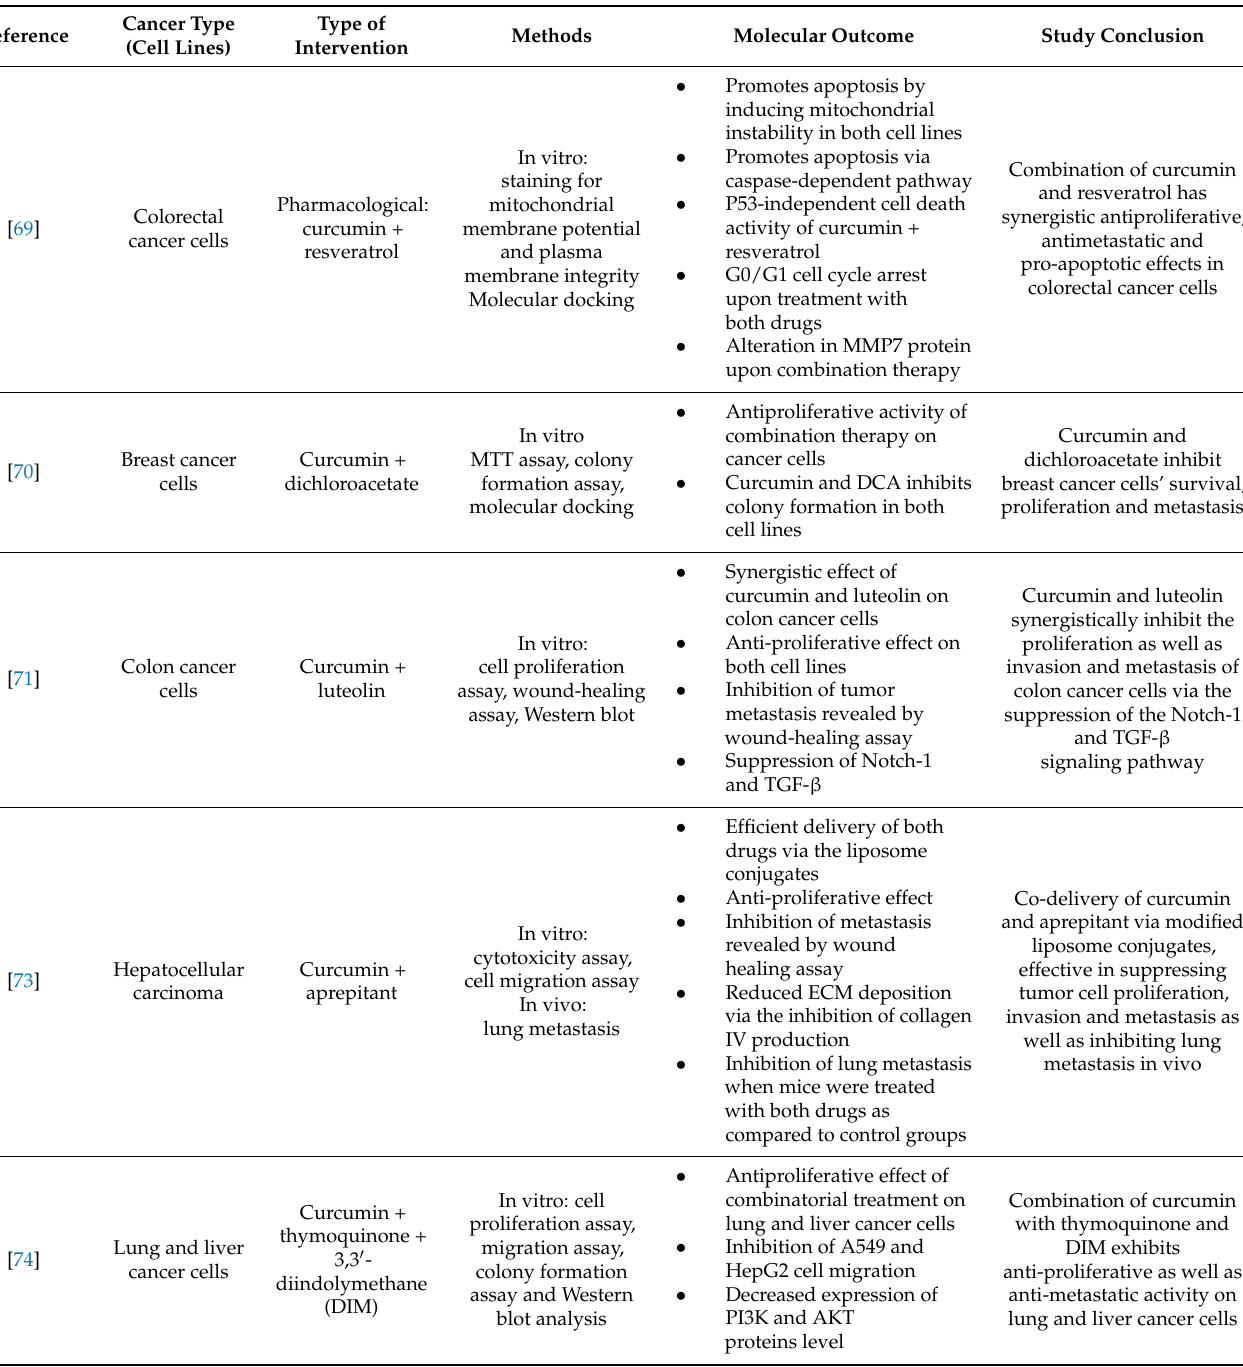
Table 1. Table summarizing the combination therapy in the past five years of curcumin and chemother- apeutic agents resveratrol, DCA, luteolin, aprepitant, WFB, thymoquinone and DIM in metastatic, invasive and proliferative cancer